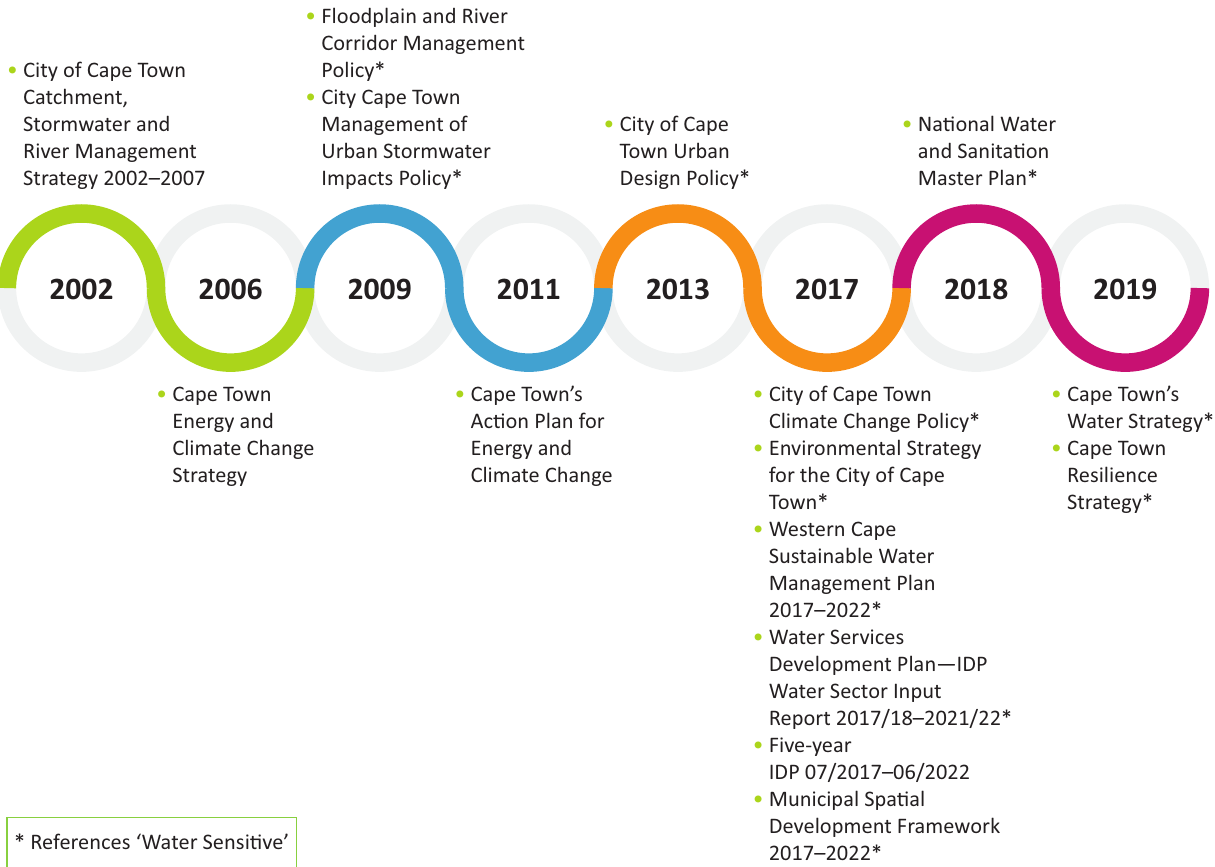
Figure 3. Timeline of selected water policy in Cape Town illustrating the emergence and evolution of WSD/WSC